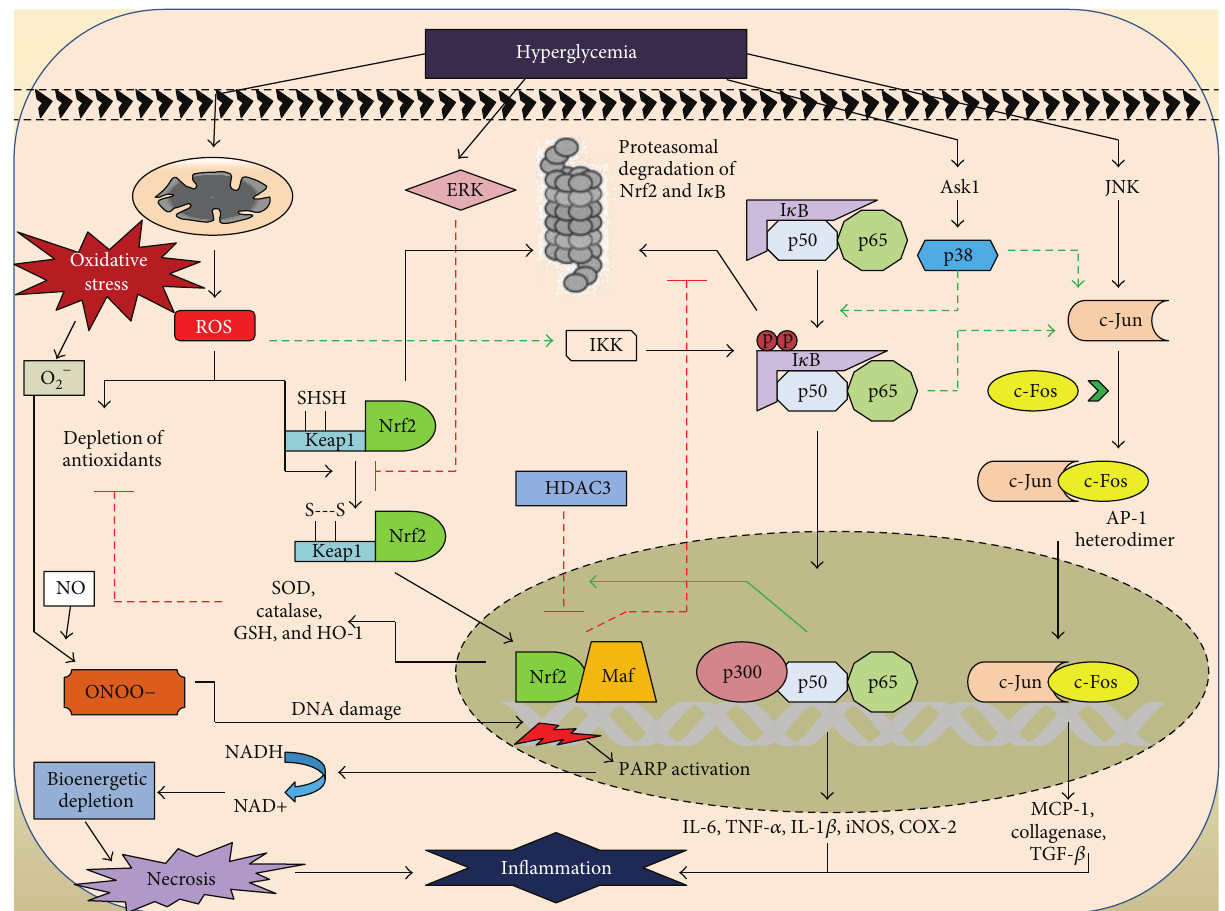
Figure 2: Crosstalk between oxidative stress and inflammation. Hyperglycemia mediated oxidative stress and inflammatory pathways are known to interact with each other at various levels. ROS activates nuclear factor (erythroid-1) related factor (Nrf2) by directly oxidising the thiol residues on kelch-like ECF associated protein (Keap-1). Nrf2 then migrates into the nucleus to activate antioxidant response elements (ARE) of genome. However, this Nrf2 activation by hyperglycemia is inhibited through extracellular related kinase activation (ERK). ROS also activates inhibitory kappa B kinase (IKK), which then phosphorylates the inhibitory kappa B protein (I 𝜅 B); the latter combines with cytosolic NF- 𝜅 B complex ant thus preventing its transcription. Phosphorylation of I 𝜅 B labels it for ubiquitination and proteasomal degradation and, hence, releases NF- 𝜅 B complex to enter into nucleus, which then expresses several proinflammatory mediators. Similarly, oxidative stress mediated c-JUN N terminal kinases (JNK) activation mediates the c-JUN component of activator protein-1 (AP-1) activation, which then combines with c-FOS subunit. The resulting AP-1 heterodimer binds with genome and increases production of various vascular inflammatory mediators. Oxidative stress mediated PARP activation also leads to inflammation through necrotic cell death. Nrf2 inhibits I 𝜅 B degradation and thus prevents NF- 𝜅 B mediated inflammation. NF- 𝜅 B also prevents the Nrf2 signalling through histone deacetylases (HDAC3) recruitment (ASK-1-apoptosis signalling related kinase-1 and MCP-1-monocyte chemoattractant protein-1).